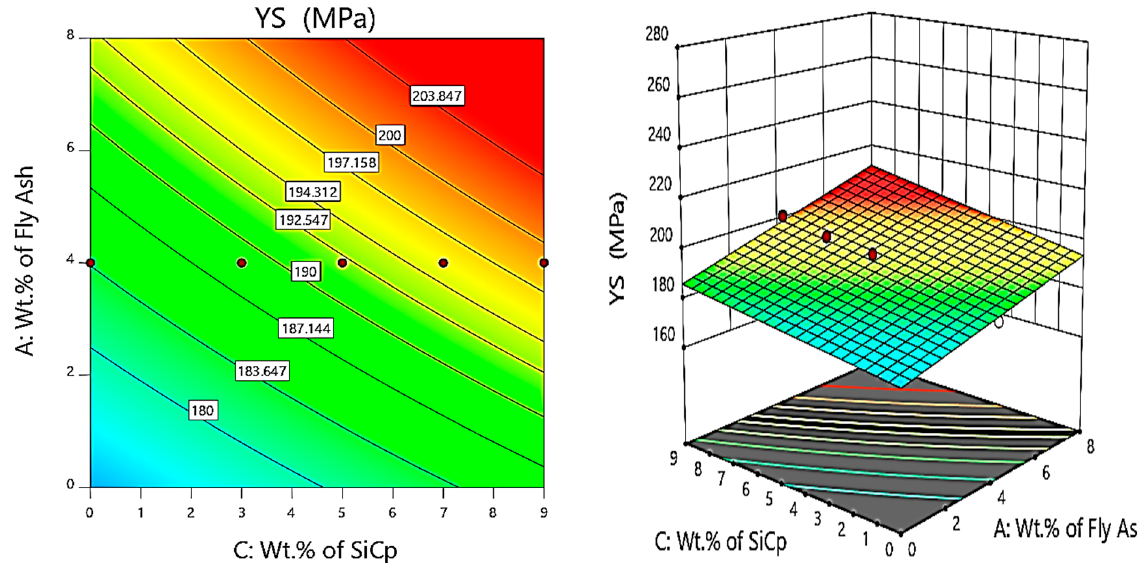
Figure 14. Contour and 3D surface plots for variation of YS with varying wt.% of SiC and fly ash.